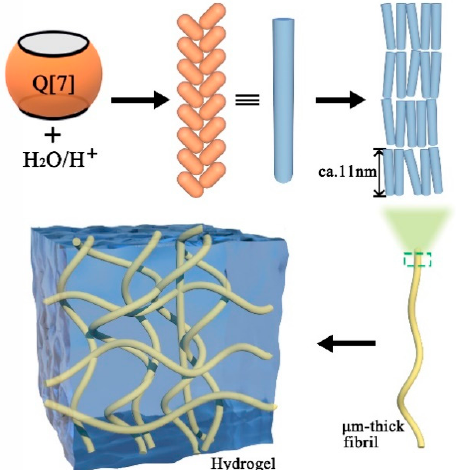
Figure 5. Q[7]-based hydrogels driven by the outer-surface